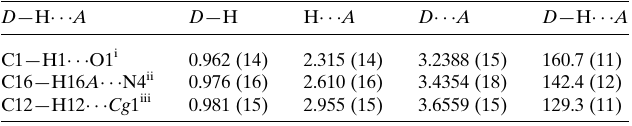
Table 2 Experimental details.